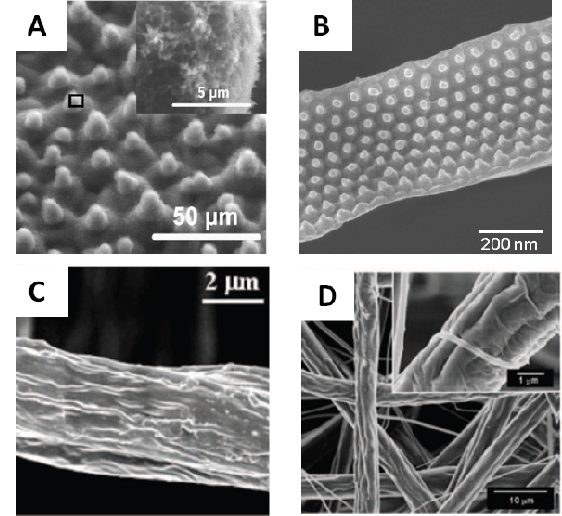
Figure 4. Examples of electrospun bio-mimics of natural hierarchical structures. ( A ) Lotus leaf; ( B ) pillared poly(methyl methacrylate) (PMMA) electrospun fiber mimic; ( C ) silver ragwort leaf; ( D ) electrospun fiber mimic made from nylon 6 and polystyrene (PS). (Figure ( A ) reprinted with permission from Wang et al. [87]. Copyright 2009 American Chemical Society; Figure ( B ) reprinted with permission from Chen et al. [88]. Copyright 2012 American Chemical Society; Figure ( C ) reprinted with permission from Miyauchi et al. [89]. Copyright 2006 IOP Science; Figure ( D ) reprinted with permission from Li et al. [90]. Copyright 2009 American Chemical